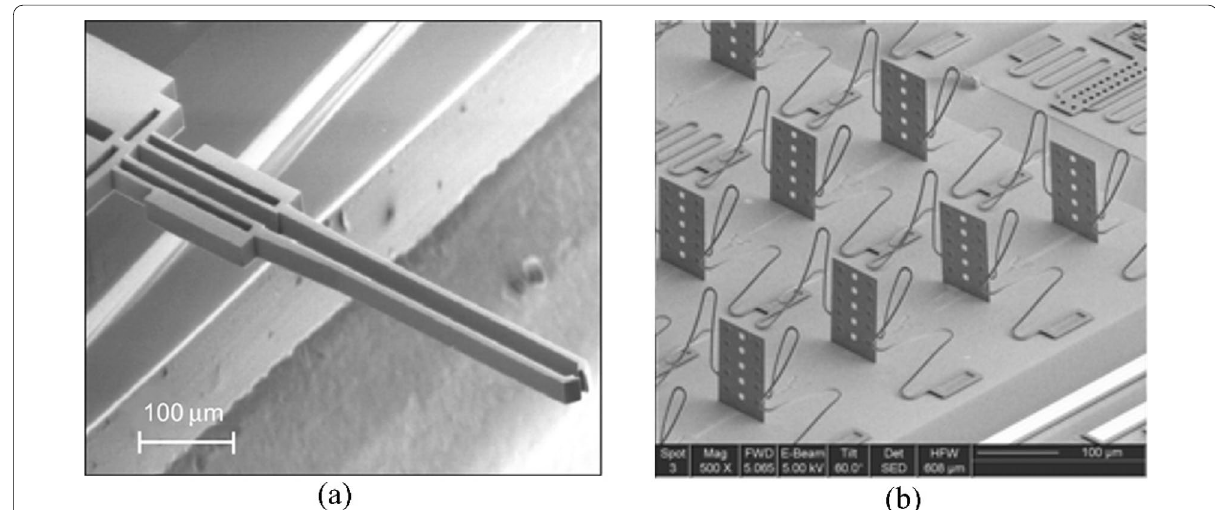
Figure 9 CMMs fabricated using SU-8: ( a ) Microgripper with integrated thermal actuator [88] (©IEEE. Adapted by permission of IEEE. Permission to reuse must be obtained from the rightsholder), ( b ) 90° folded Tsang mechanism [44] (©IOP. Adapted by permission of IOP. Permission to reuse must be obtained from the